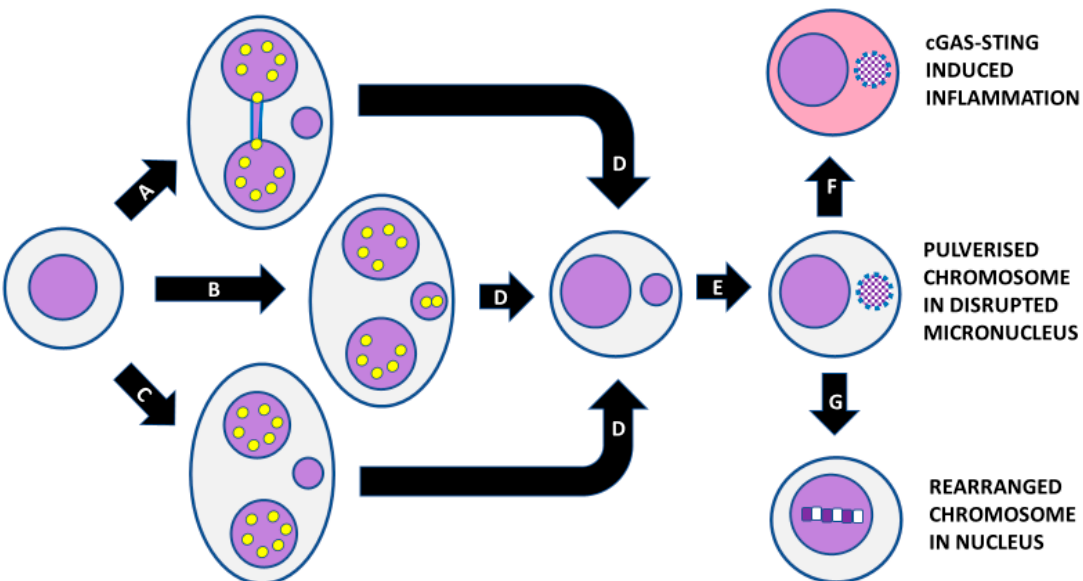
Figure 7. Consequences of micronucleus formation. Micronucleus formation at the binucleated cell stage as a result of ( A ) mis-repair of DNA breaks leading to a nucleoplasmic bridge and an acentric chromosome fragment, ( B ) the whole chromosome as a result of mal-segregation, and ( C ) lagging acentric chromosome fragments as a result of unrepaired DNA breaks. ( D ) Mononuclear cell with a micronucleus after completion of cytokinesis. ( E ) Shattering of chromosomes trapped in a micronucleus and disruption of the nuclear envelope of the micronucleus. ( F ) Leakage of DNA from the micronucleus, leading to activation of cyclic GMP-AMP synthase–Stimulator of Interferon Genes (cGAS-STING) mechanism and induction of inflammatory cytokines. ( G ) Integration of pulverised chromosomes within the main nucleus and error-prone repair by non-homologous end-joining, resulting in a greatly rearranged mutant chromosome. Yellow dots represent centromeres.